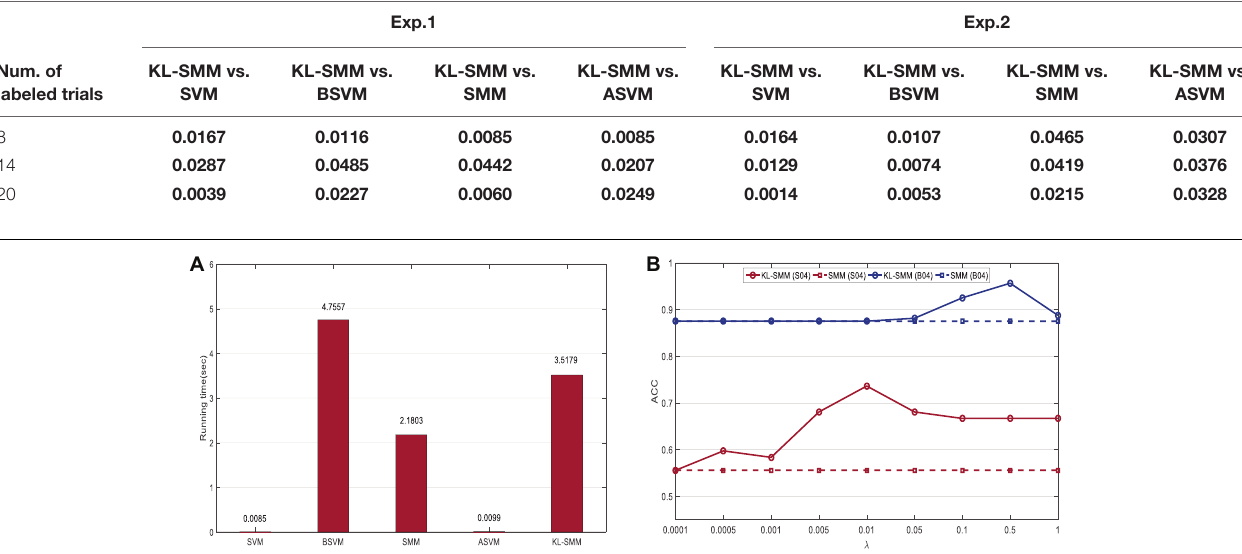
FIGURE 2 | Average classification ACCs of comparison methods with different numbers of labeled target EEG trials in Exp.1 (A) and Exp.2 (B) . TABLE 7 | Statistical significance comparisons of ACC of KL-SMM and other methods in Exp.1 and Exp.2 . Exp.1 Exp.2